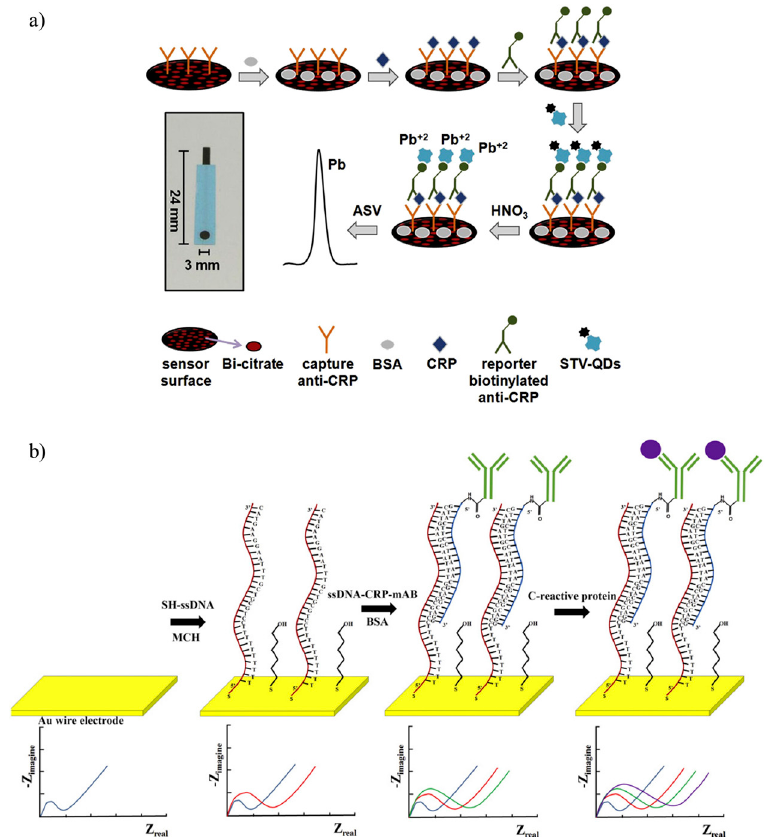
Figure 3. ( a ) Schematic process of the fabrication and working principle of the bismuth citrate-modified sandwich-type immunosensor proposed in (Reprinted with permission from [93]). The detection was performed by anodic scan voltammetry to detect the release of Pb(II) from the QDs in HNO 3 ; ( b ) top: DNA-direct immobilization of anti-CRP onto a gold nanowire; bottom: changes in the electrochemical impedance after each step ([97], licensed under CC BY-NC-ND